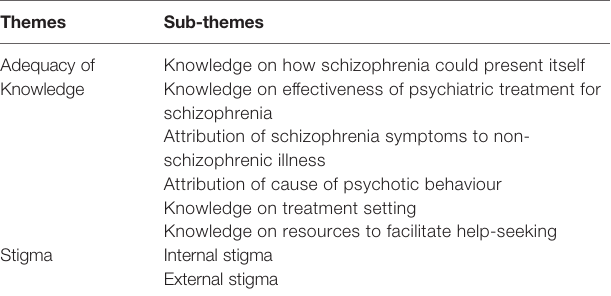
TABLE 3 | Factors in fl uencing professional help-seeking during